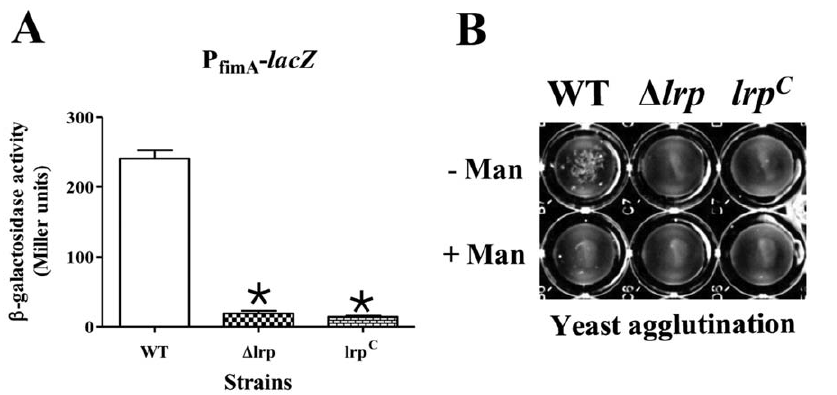
Figure 1. Expression of type 1 fimbrial operon and the associated phenotype in the wild-type (WT, x 3761), D lrp ( x 9411), and lrp C ( x 9448) strains. (A) b -galactosidase assay for the P fimA - lacZ fusions in each strain is shown. *, P , 0.05 (B) Mannose-sensitive yeast agglutination assay to assess type 1 fimbriae synthesis. Representative images from several experiments are shown. Bacterial cells were statically grown in LB broth for 24 h at 37 u C.